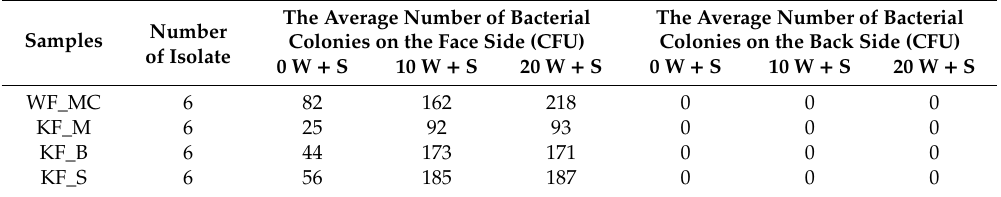
Table 7. Results of microbial barrier permeability: the average number of bacterial colonies (CFU) on the back and face